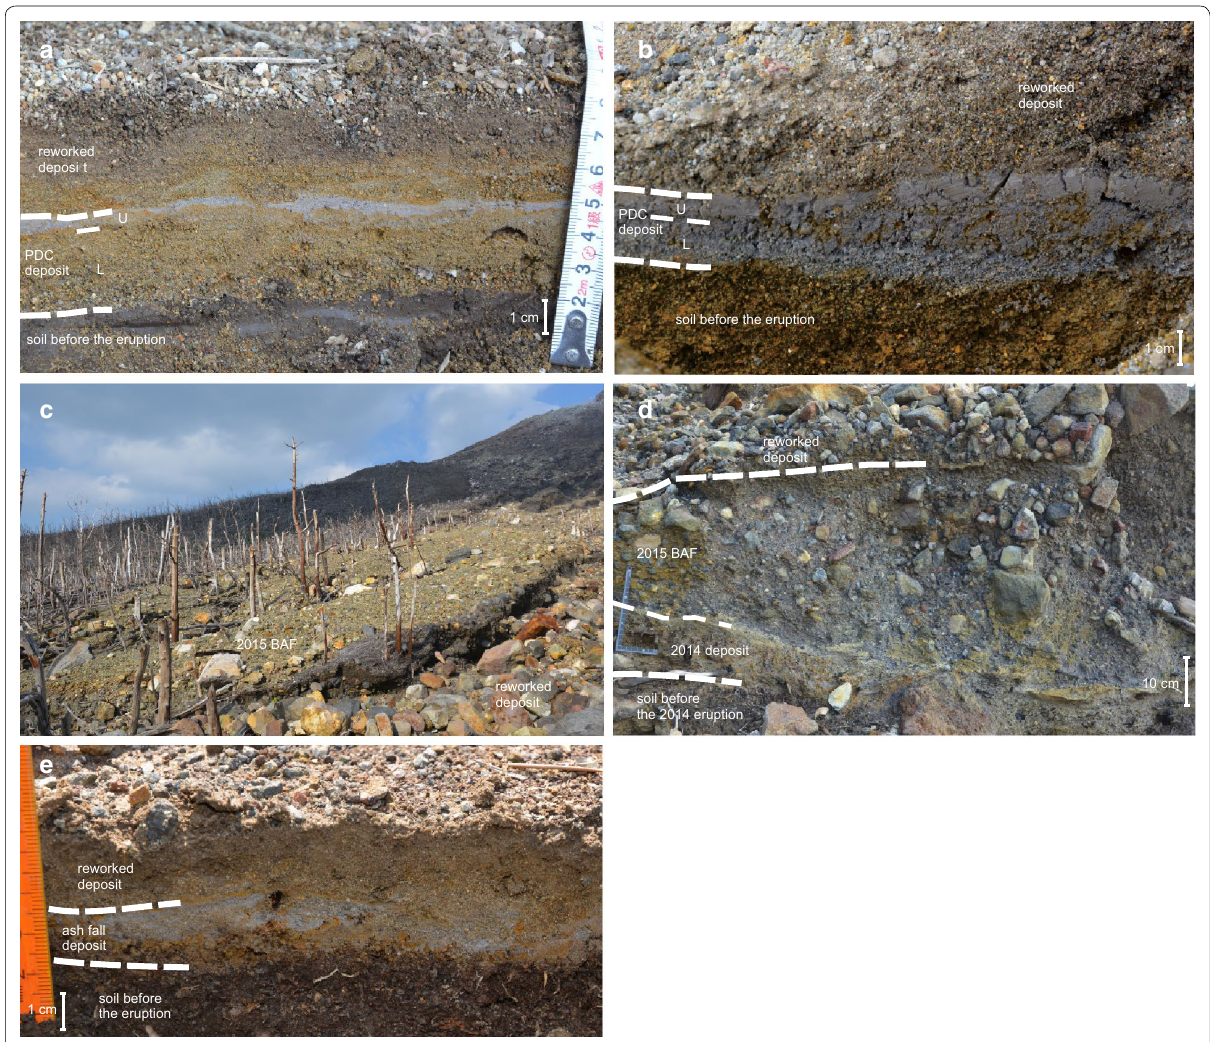
Fig. 6 a Deposit of the PDC in Zone d ~ 2 km from the crater (Loc. 1). Photograph was taken in November 2016, ~ 1.5 years after the eruption. The deposit is subdivided into L and U parts. L1, L2, and U indicate the level of sampling for grain-size analysis. b Deposit of the PDC in Zone e, ~ 1 km from the crater (Loc. 2). Photograph taken in March 2017. The deposit is divided into the normal-grading volcanic sand layer in the lower portion (L) covered by the fine grained volcanic ash (U). c Block-and-ash flow deposit at Loc. 4, ~ 1 km from the crater. Photograph taken in March 2017. The deposit exhibits yellowish color in March 2017, 1.5 years after the eruption due to the surface weathering of the materials. d Cross section of the block-and-ash flow deposit of the PDC in Zone c (Loc. 4). Photograph taken in March 2017. The deposit overlies the 2014 tephra which contains plenty of plant fragments. e Ash-fall deposit in Zone f (Loc. 3). The level for sampling for grain-size analysis is indicated by bar with